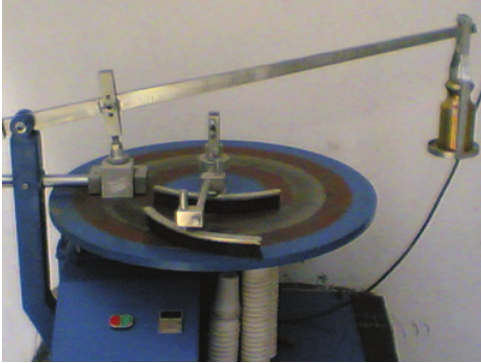
Figure 2: Abrasion test apparatus (Bohme